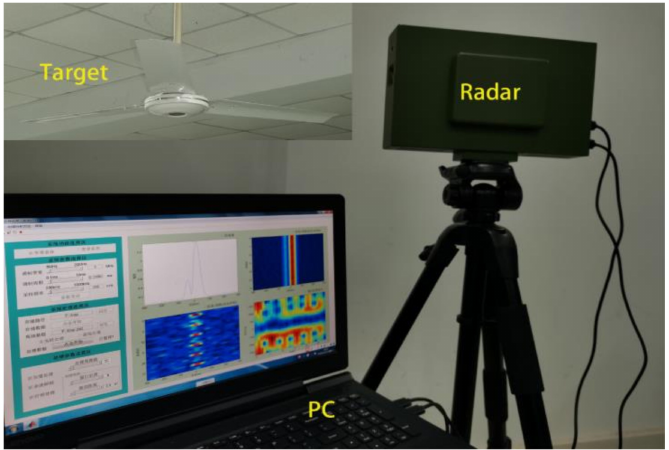
Figure 4. Experimental